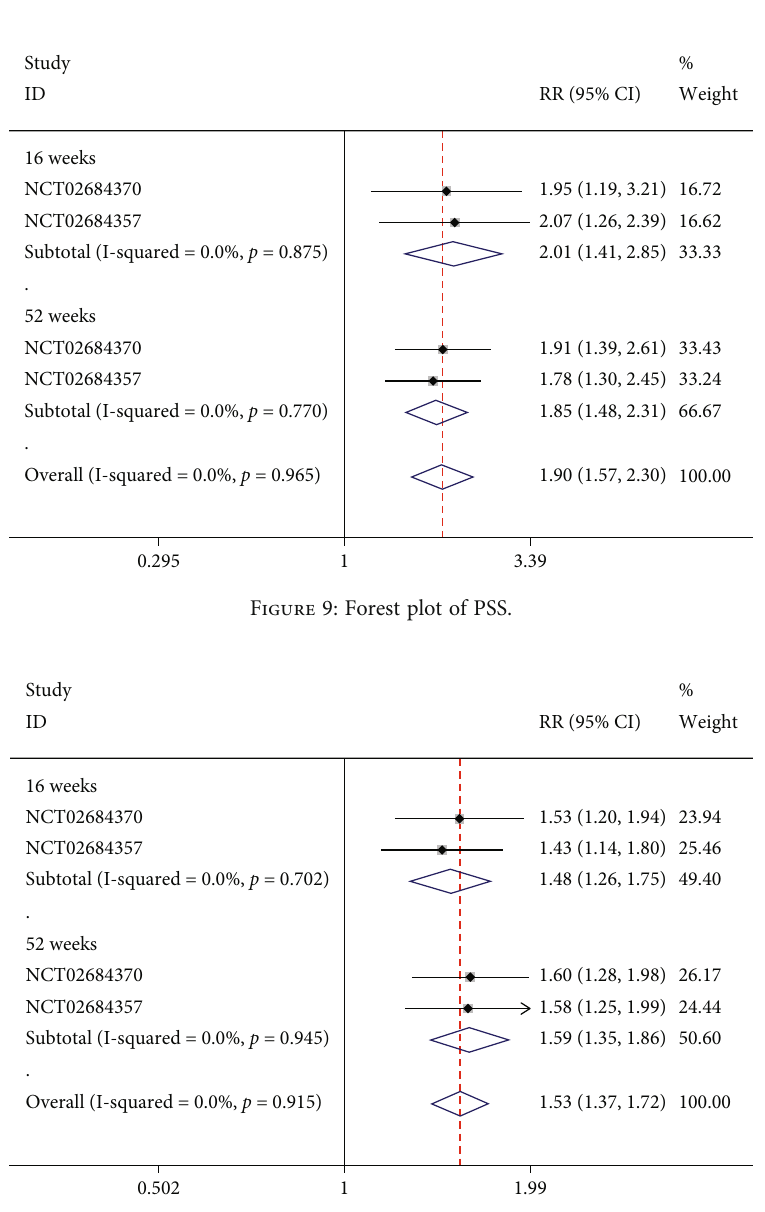
Figure 10: Forest plot of quality of